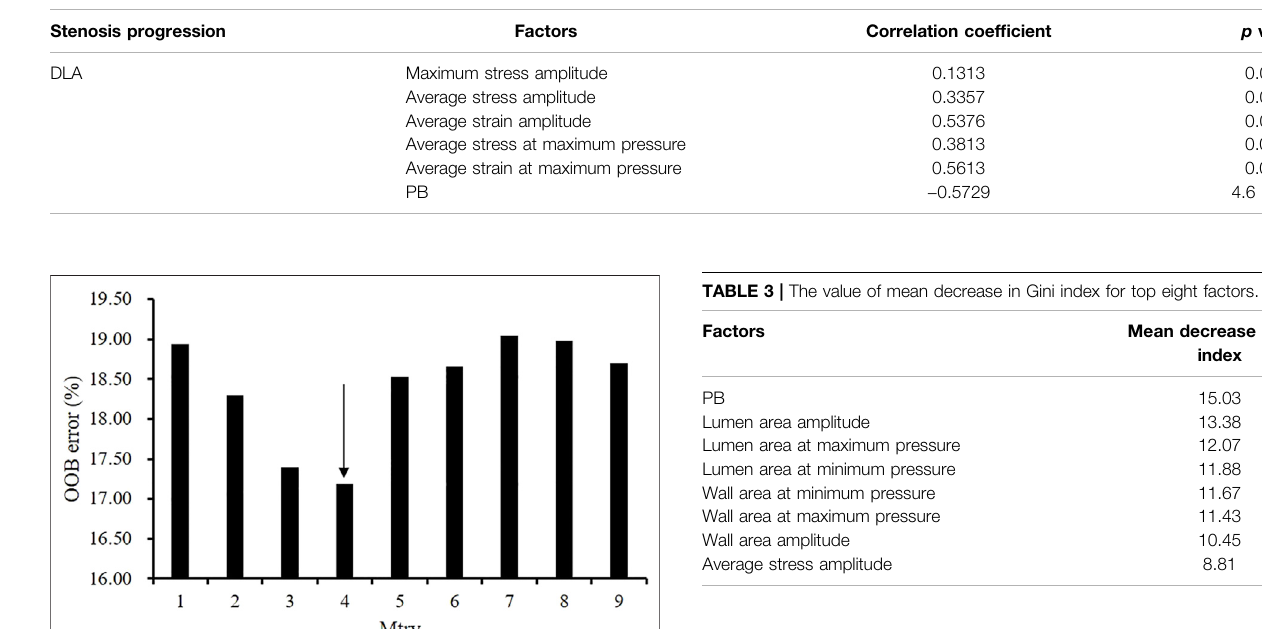
TABLE 2 | The correlation of baseline factors and stenosis progression.